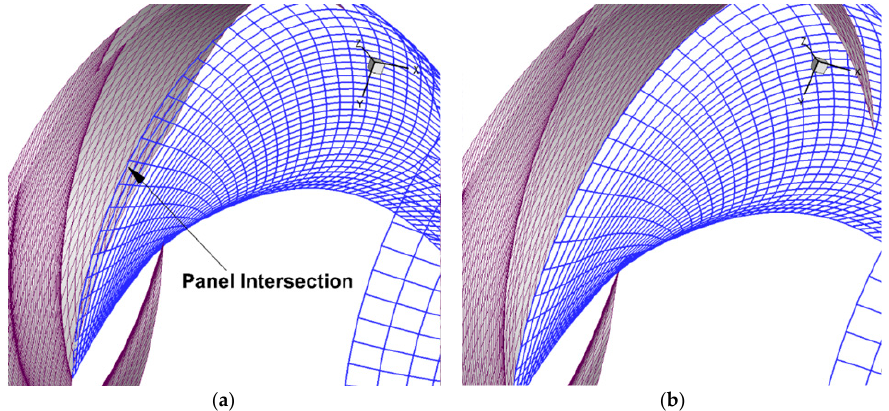
Figure 18. Relative distribution of the blade wake and duct panels. Mismatched panel edges are shown at the blade wake/inner duct intersection ( a ), while adapted panels with matched edges are shown in Option 2 ( b ). J. Mar. Sci. Eng. 2018 , 6 , x FOR PEER REVIEW